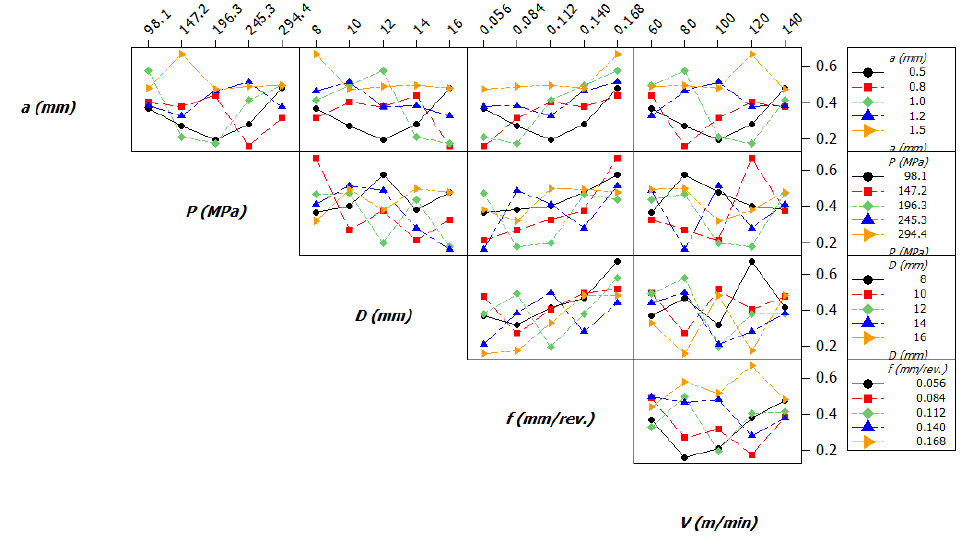
Figure 8. The interactive effects of machining parameters on the decreased roughness rate.